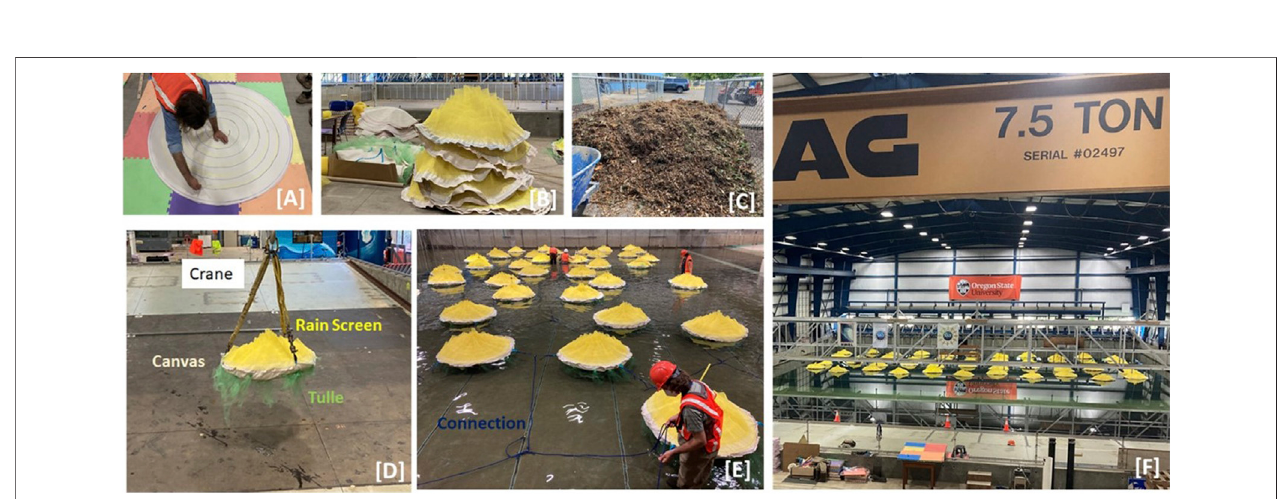
FIGURE 4 | Construction of the individual mats and the network, from (A) cutting and marking canvas to 5 ft diameter, (B) sewing rain screen (yellow) to the top canvas piece and tulle (light green) with a webbing triangle (light blue) to the bottom piece, (C) using wood discard fragments to stuff the units, (D) lifting a stuffed and sewn unit into the basin where (E) it is tied to other units using nylon rope (dark blue) to fi nally set the (F) completed network in 1.37 m of water depth.